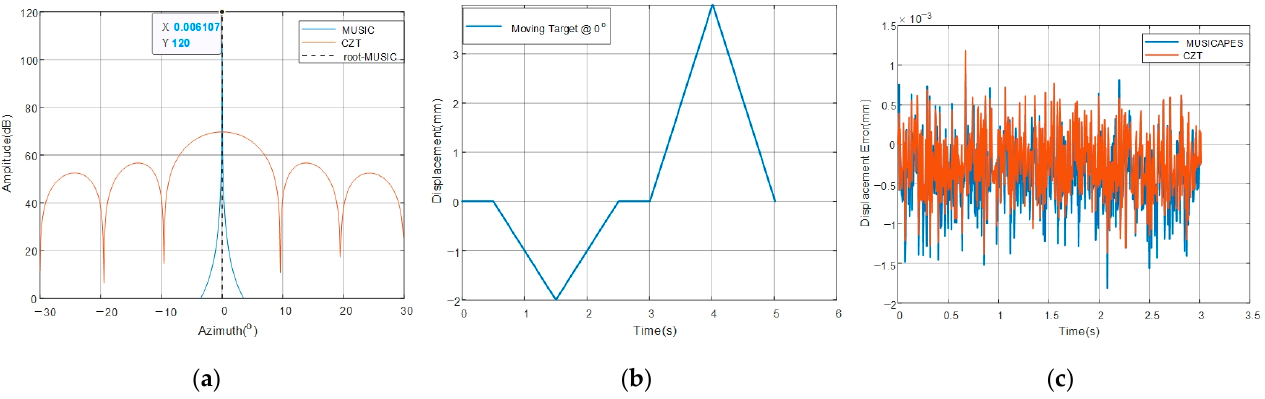
Figure 4. The simulated displacement curve and the estimated ones by the two algorithms. ( a ) DOA curves in a one-target situation; ( b ) real value of simulated displacement curve; ( c ) errors between the estimated displacements and the simulated one. the estimated displacements and the simulated